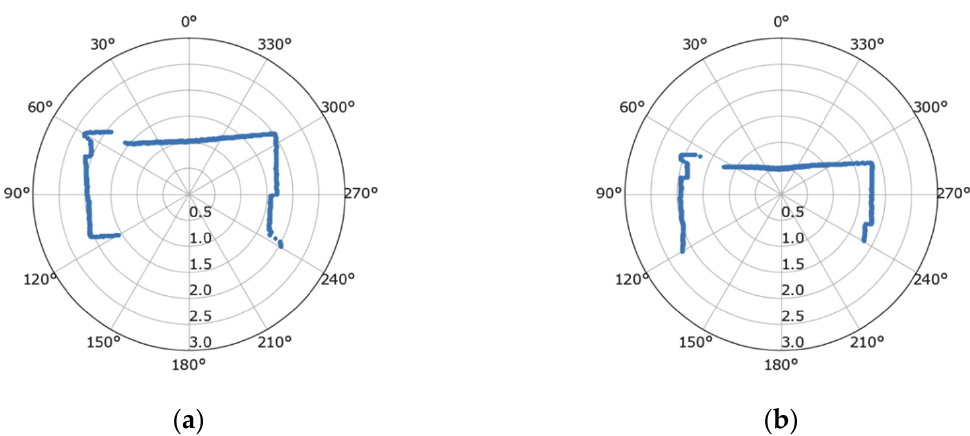
between 50 and 300 cm, and the same measurement was repeated one hundred times for each position. Figure 10a,b show the polar diagrams obtained at the two distances.